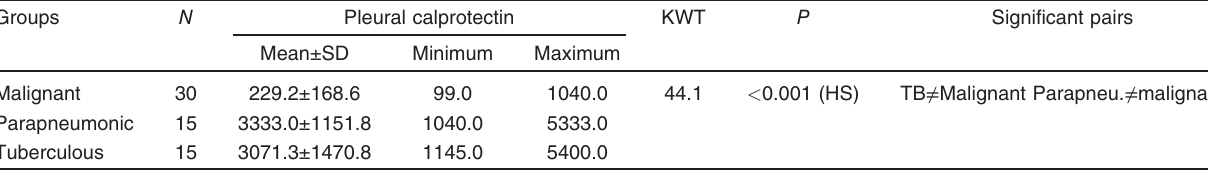
Table 3 Statistical analysis of pleural calprotectin level in tuberculous and parapneumonic groups Effusion N Pleural calprotectin